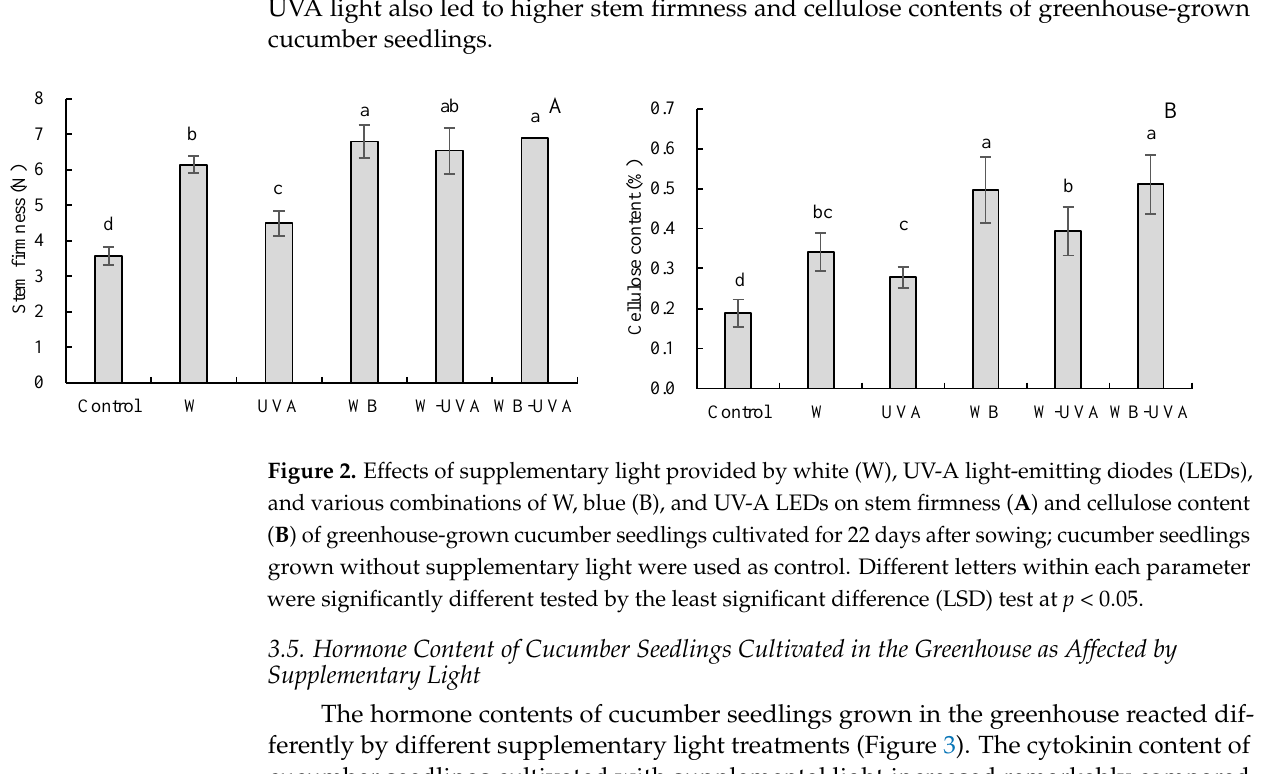
The hormone contents of cucumber seedlings grown in the greenhouse reacted dif- ferently by different supplementary light treatments (Figure 3). The cytokinin content of cucumber seedlings cultivated with supplemental light increased remarkably compared with those grown with natural light only. Clearly, UVA light was effective in promoting the cytokinin content of cucumber seedlings. Moreover, the cytokinin content of cucumber seedlings grown with WB-UVA increased by 1-fold compared with those grown under the control treatment.